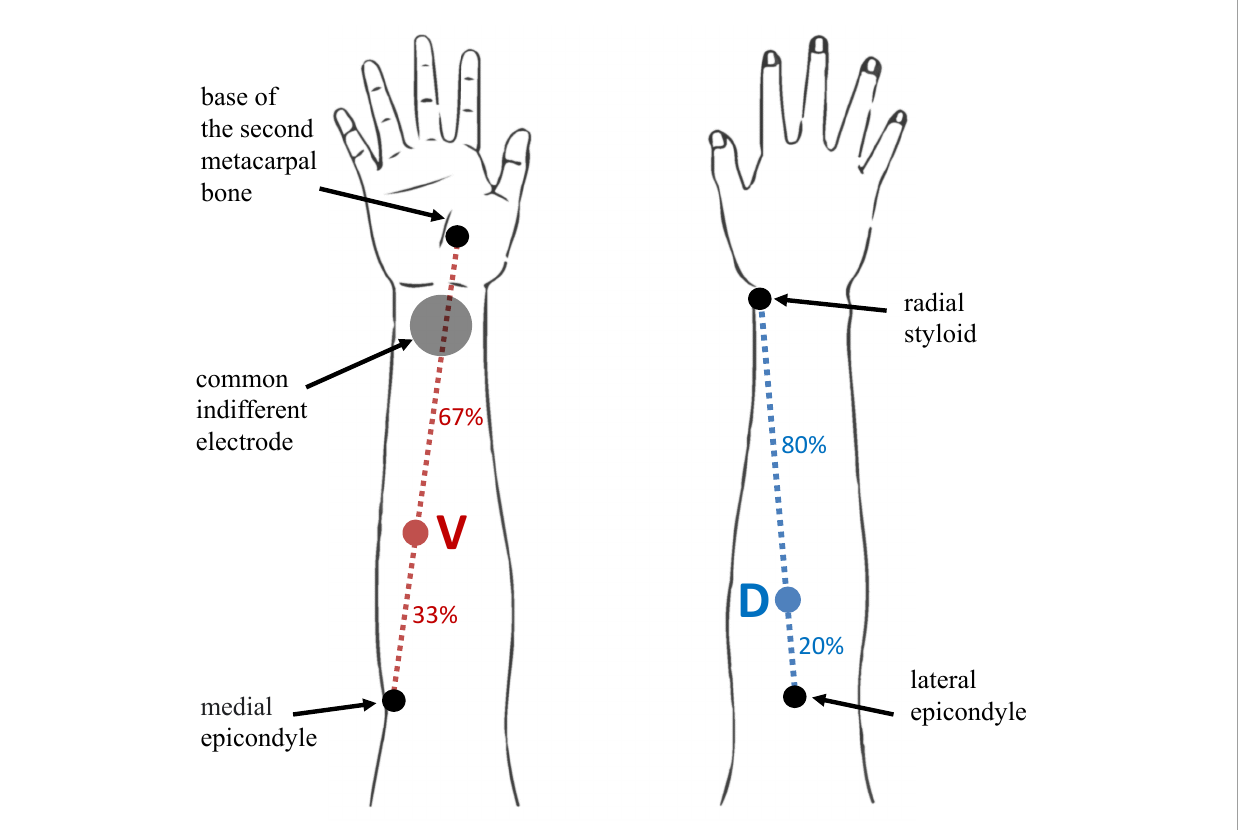
FIGURE1 Schematics of D and V location positions on the user’s forearm, and indifferent electrode. Location D is identified at proximal 20% of the line length from the lateral humeral epicondyle to the radial styloid (blue dotted line) with the forearm in pronation. Location V is identified at proximal 33% of the line connecting the medial epicondyle and the base of the second metacarpal bone with the forearm in supination. Locations D and V are marked with blue and red colored circles on the dotted lines of the same color, respectively. The anatomical markers for determining the reference lines are marked with black circles and labeled accordingly. The indifferent electrode position over the volar aspect of the wrist is marked with gray full